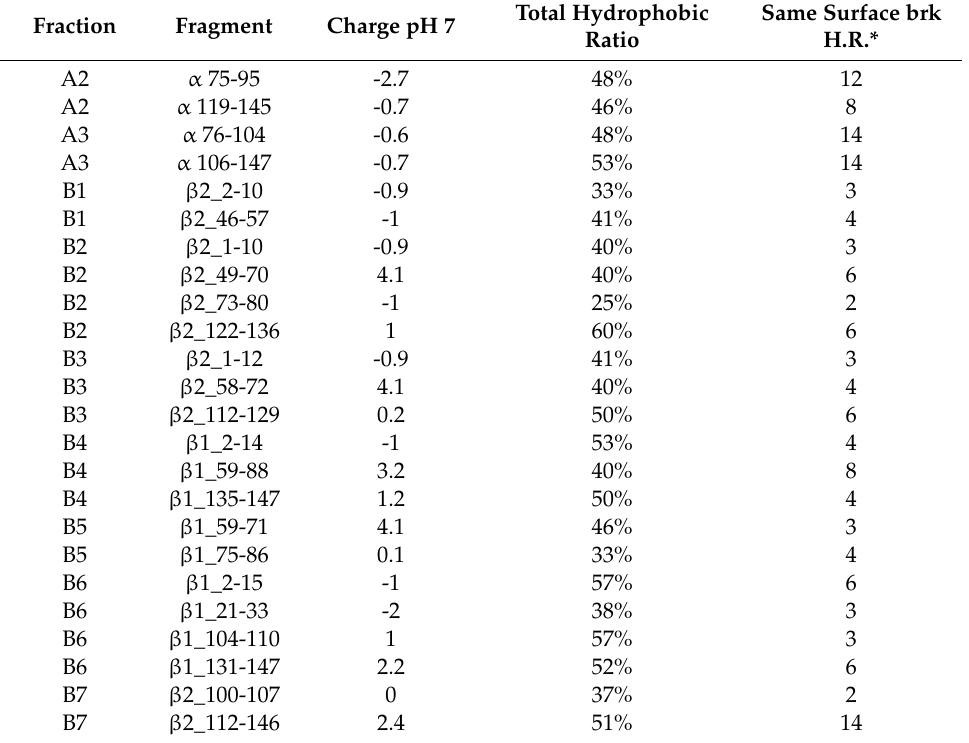
Table 5. Fragments chemical properties. Chemical features of the fragments with alpha-helix predicted structure. H.R. stands for hydrophobic residue. α stands for alpha chain, β 1 stands for beta-1 chain and β 2 stands for beta-2